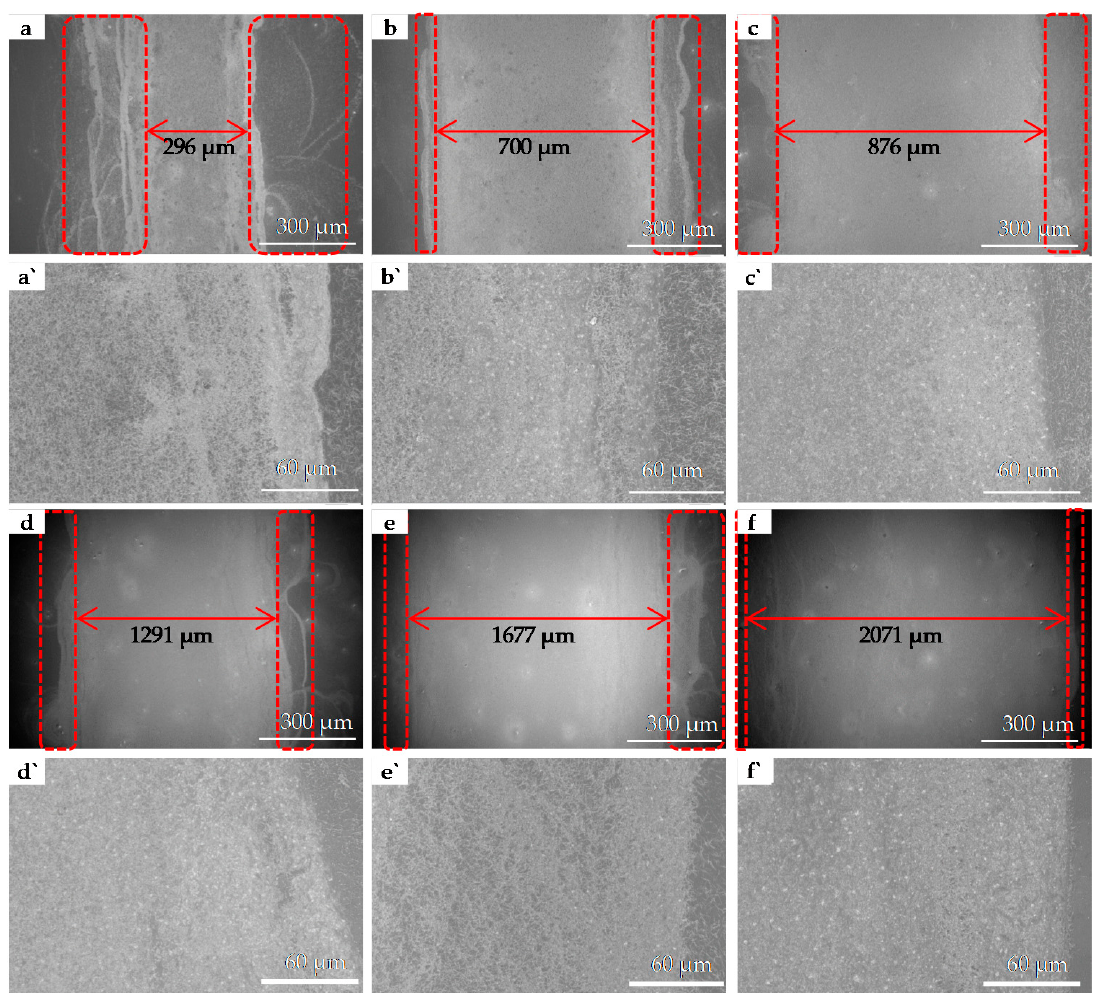
Figure 12. SEM images of the red frame in Figure 11 from the printed pattern ( a ) to ( f ), and ( a‘ )–( f‘ ) are the corresponding local magnification.